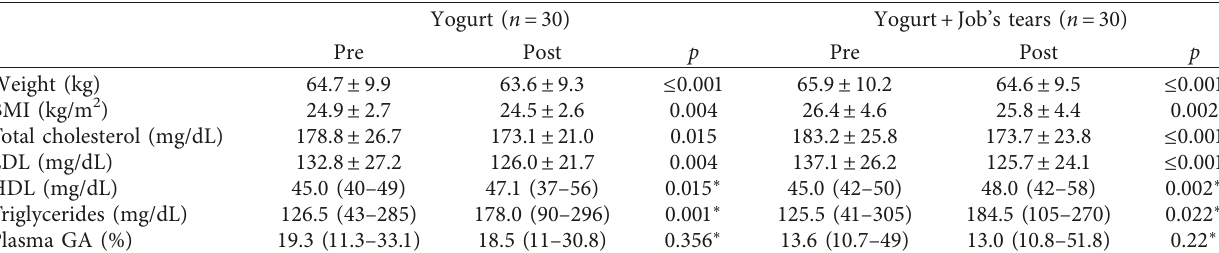
Table 2: Effect of intervention within the groups.